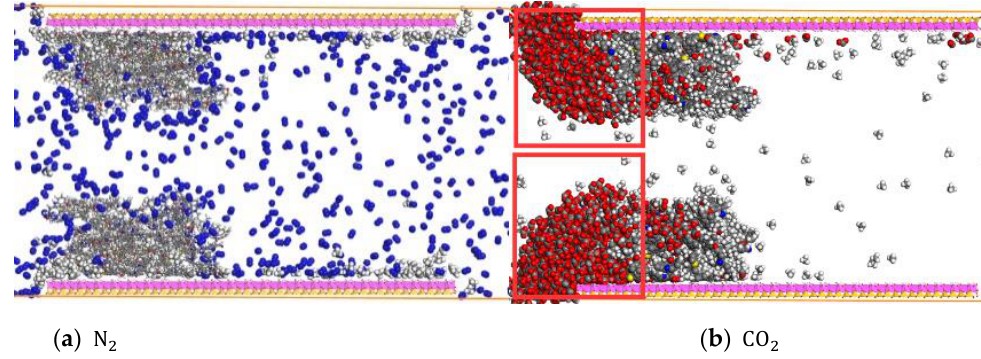
Figure 13. Displacement capacity of CH 4 by gas with different proportions over time.